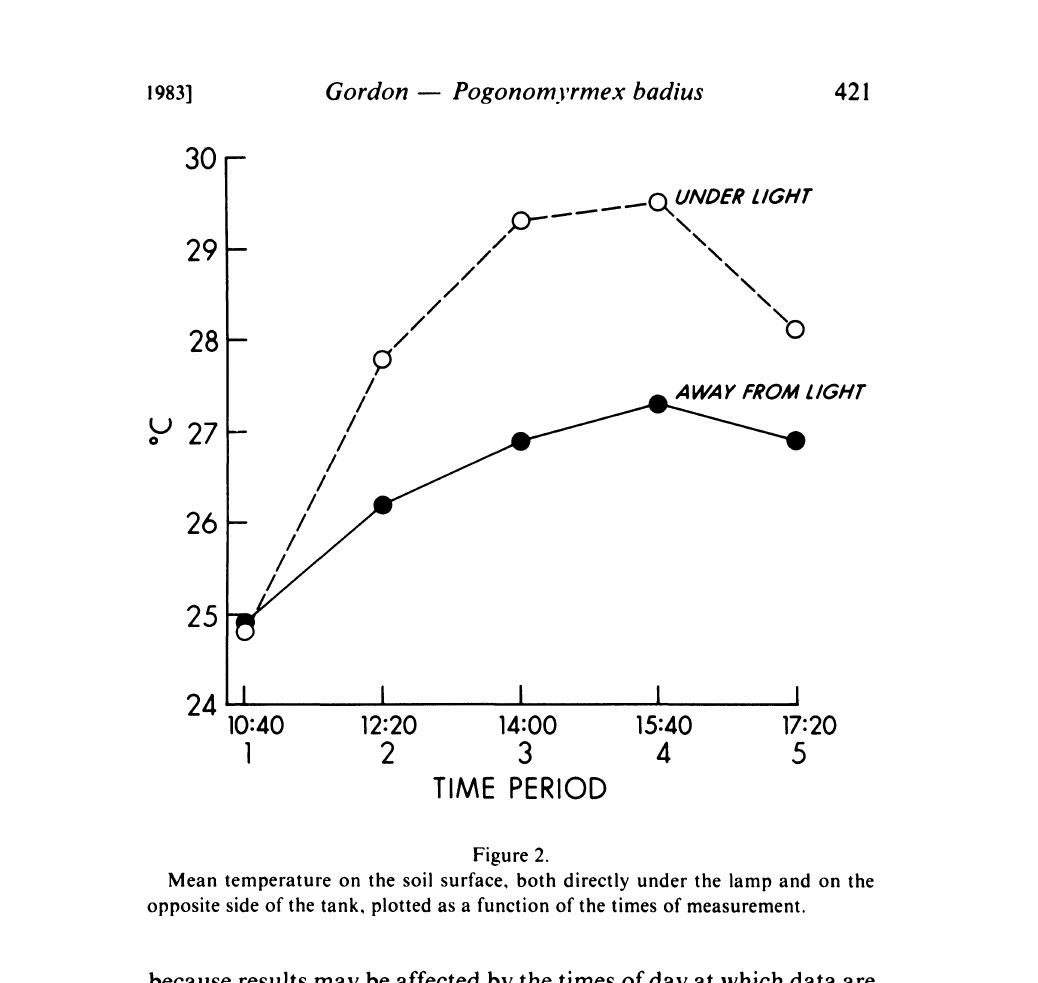
Figure 2. Mean temperature on the soil surface, both directly under the lamp and on the opposite side of the tank, plotted as a function of the times of measurement. because results may be affected by the times of day at which data are collected (e.g., Gordon 1983d and